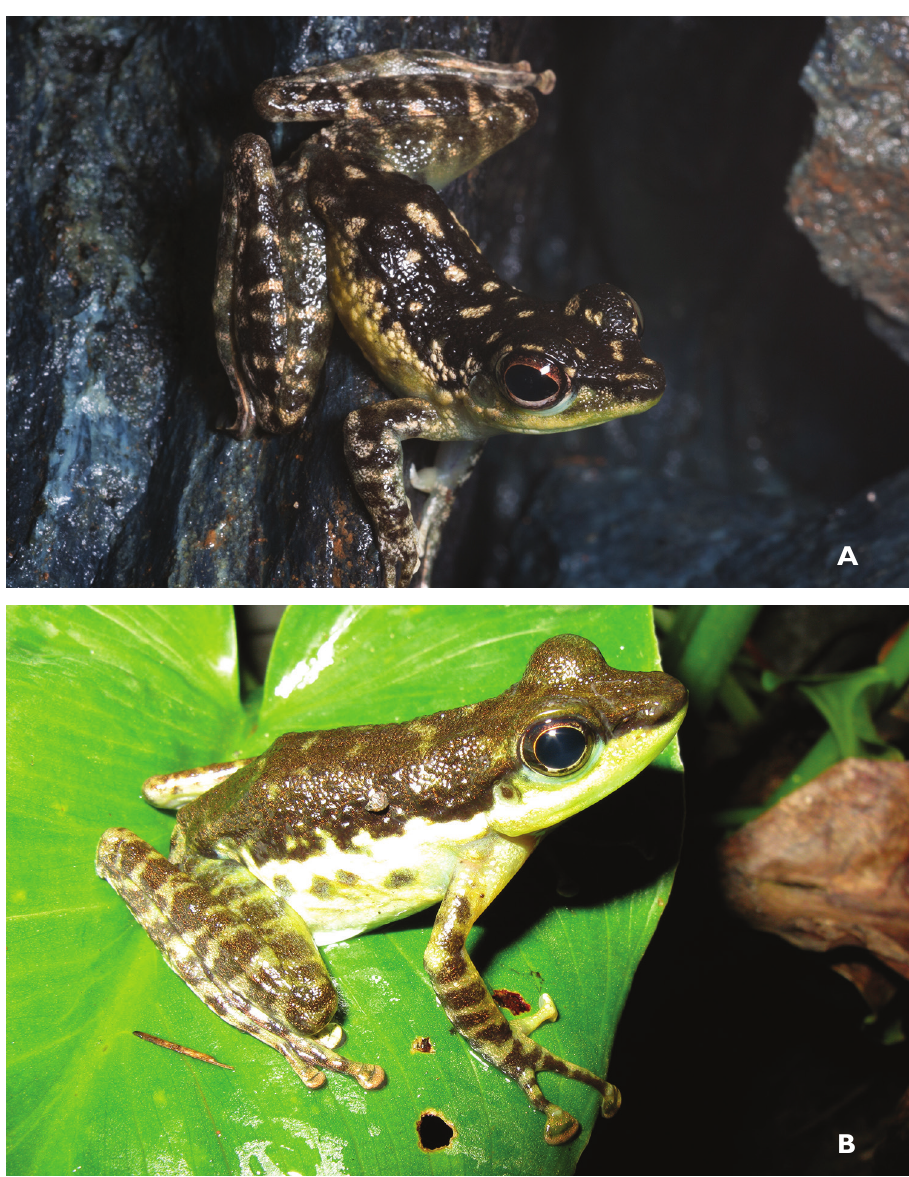
Figure 27. Staurois natator male ( A KU 327816) from Municipality of Mambajao, Mt. Mambajao, Camiguin Sur Island (Photo: CDS) and female ( B KU 319809) from 1900 masl, Mt. Balatukan, Munici- pality of Gingoog, Misamis Oriental Province. Photo: